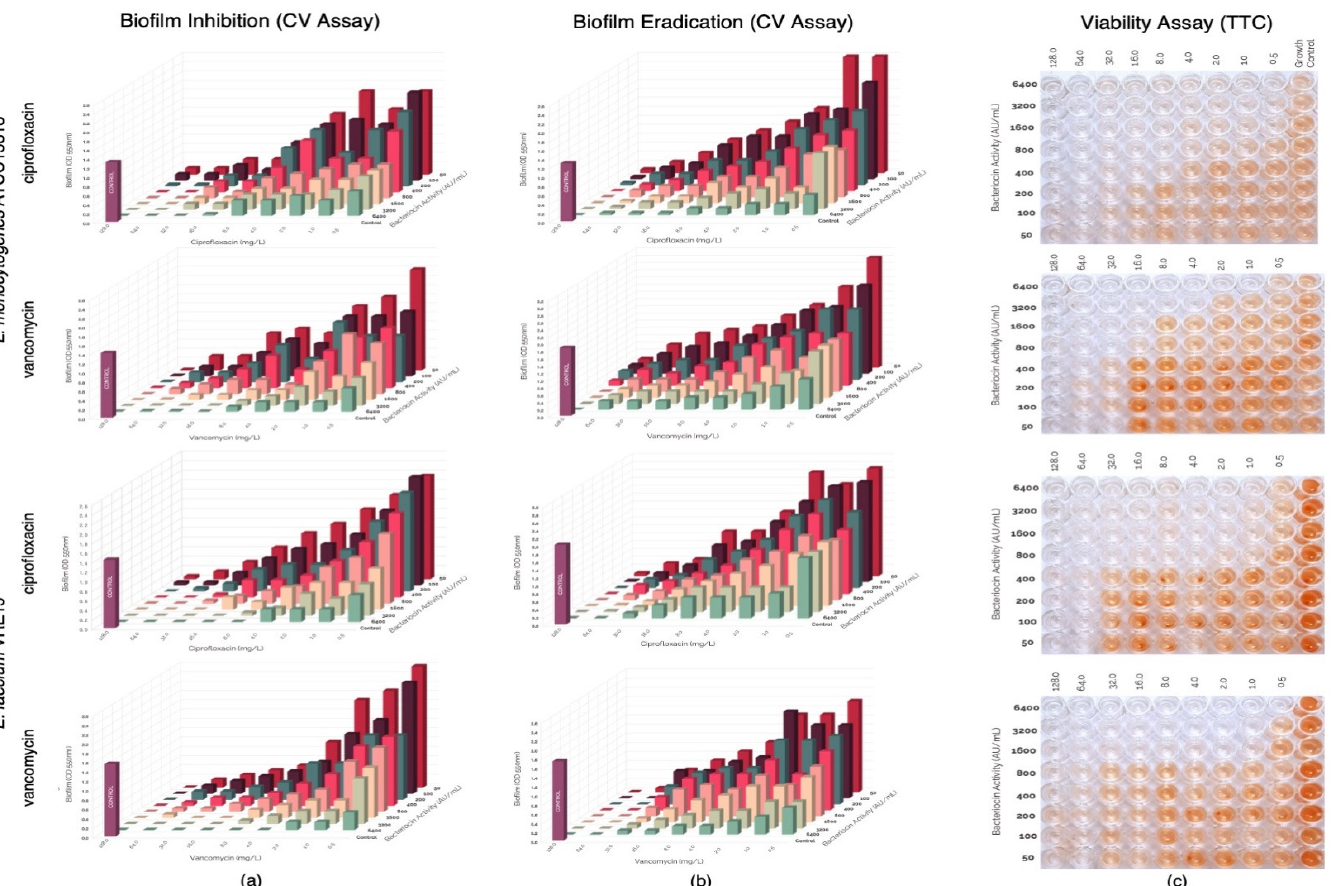
Figure 3. Evaluation of synergy between semi-purified bacteriocin ST651ea and antibiotics (ciprofloxacin or vancomycin) on the ( a ) biofilm formation and ( b ) biofilm eradication of Listeria monocytogenes ATCC15313 and Eenterococcus faecium VRE19 as demonstrated on the topographic analysis biofilms by crystal violet assay; and ( c ) confirmation of cell viability were carried out using TTC assay.